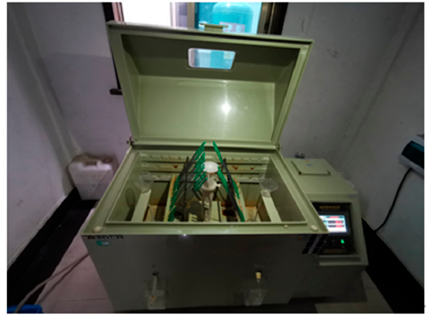
Figure 6. Corrosion fatigue fracture morphology. ( a ) Corrosion pit evolution diagram; ( b ) steel wire fracture diagram near corrosion pit. Figure 2. Salt spray corrosion tank used for corrosion. Figure 2. Salt spray corrosion tank used for corrosion. Table 1. Mechanical properties of high strength steel wire Table 1. Mechanical properties of high strength steel wire specimens.